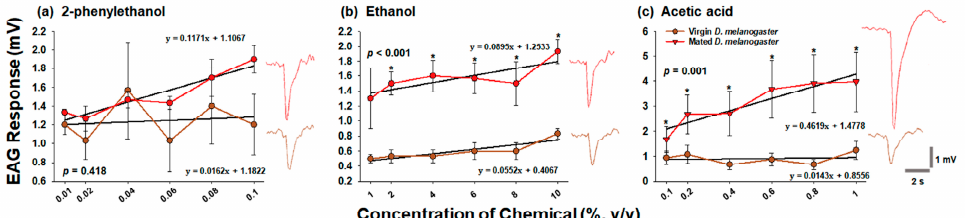
Figure 5. Comparison of EAG responses between virgin and mated female Drosophila melanogaster to ( a ) 2-phenylethanol, ( b ) ethanol, and ( c ) acetic acid. The EAG responses values of the two flies were statistically analyzed using GLM-repeated measures ANOVA ( p < 0.05). At the given concentrations of the chemicals, Student’s t -test was used to compare EAG values between virgin and mated females. Asterisks indicate significant differences ( p < 0.05). The data are presented as the mean ± standard error. Waveforms of EAG responses of virgin (brown) and mated (red) female D. melanogaster to ( a ) 0.1% 2-phenylethanol, ( b ) 10% ethanol, and ( c ) 1% acetic acid. Note that the recovery time of EAG was longer in acetic acid stimulations than that in other stimulations. EAG, electroantennogram.